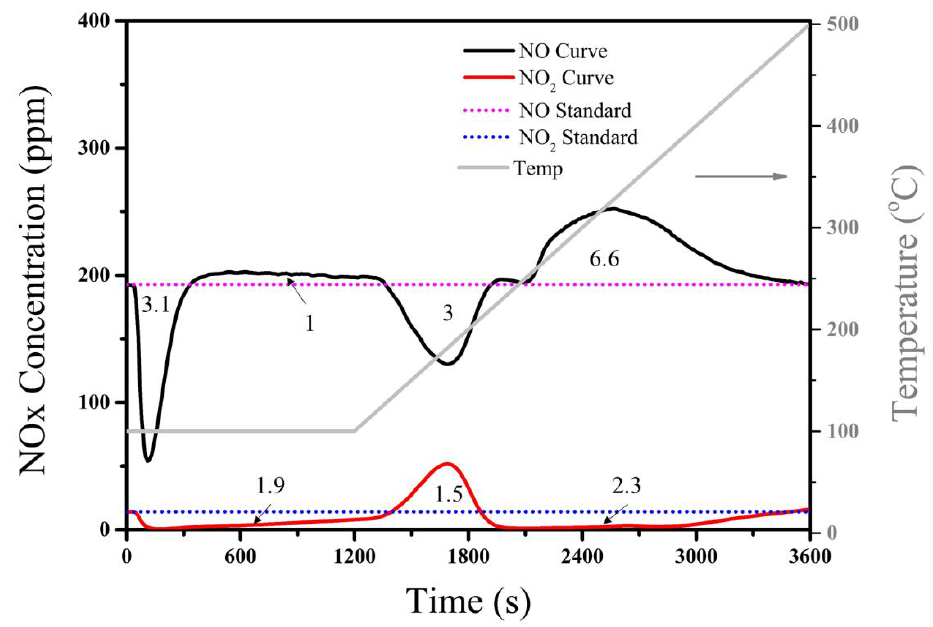
Figure 6. Transient NO x adsorption at 100 °C and temperature programmed desorption of as-pre- pared Pd/SSZ-13 when 5% H 2 O is added to the flow gas.